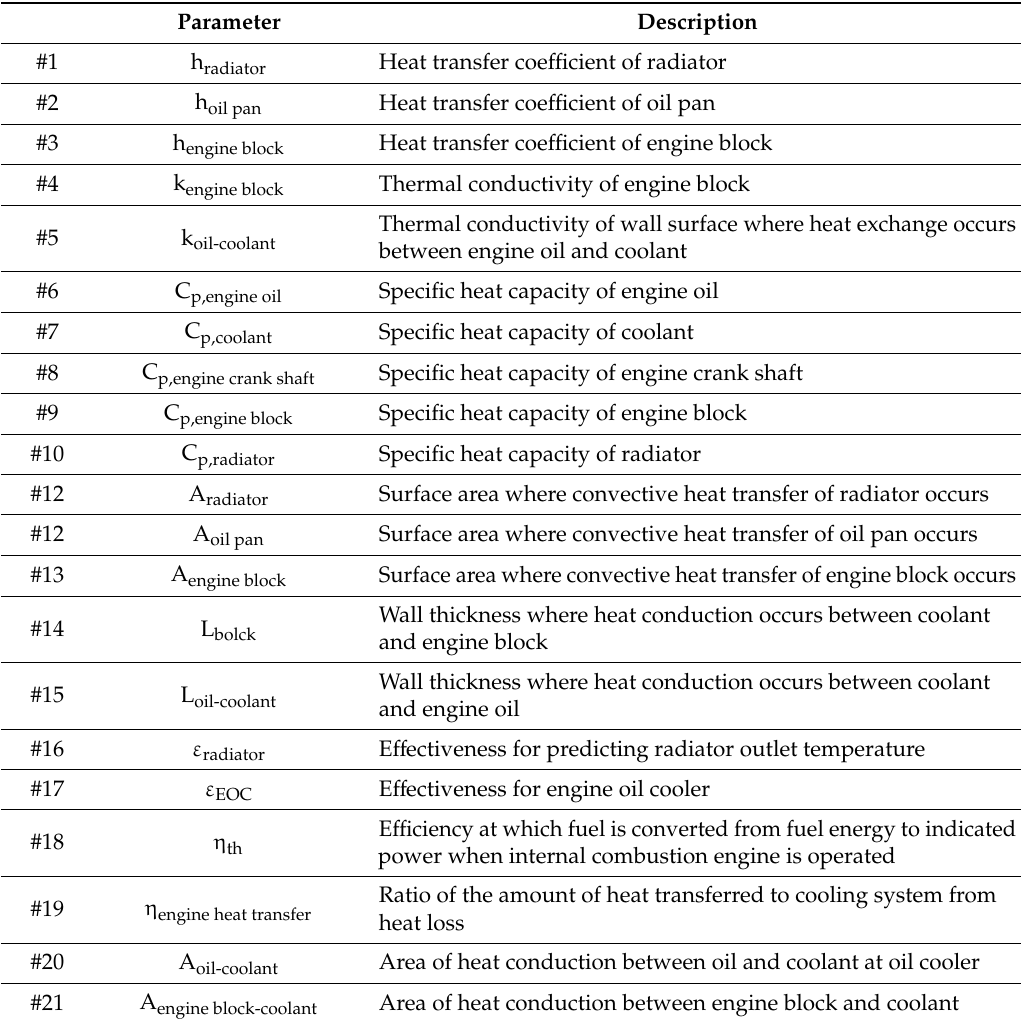
Table 2. Parameters necessary for physical models.